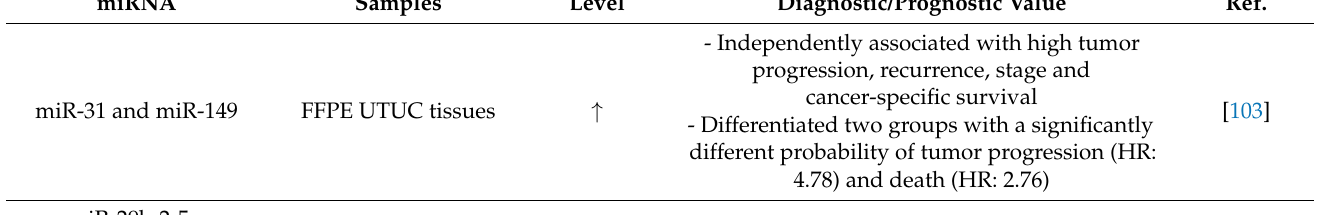
miR-31 and miR-149 FFPE UTUC